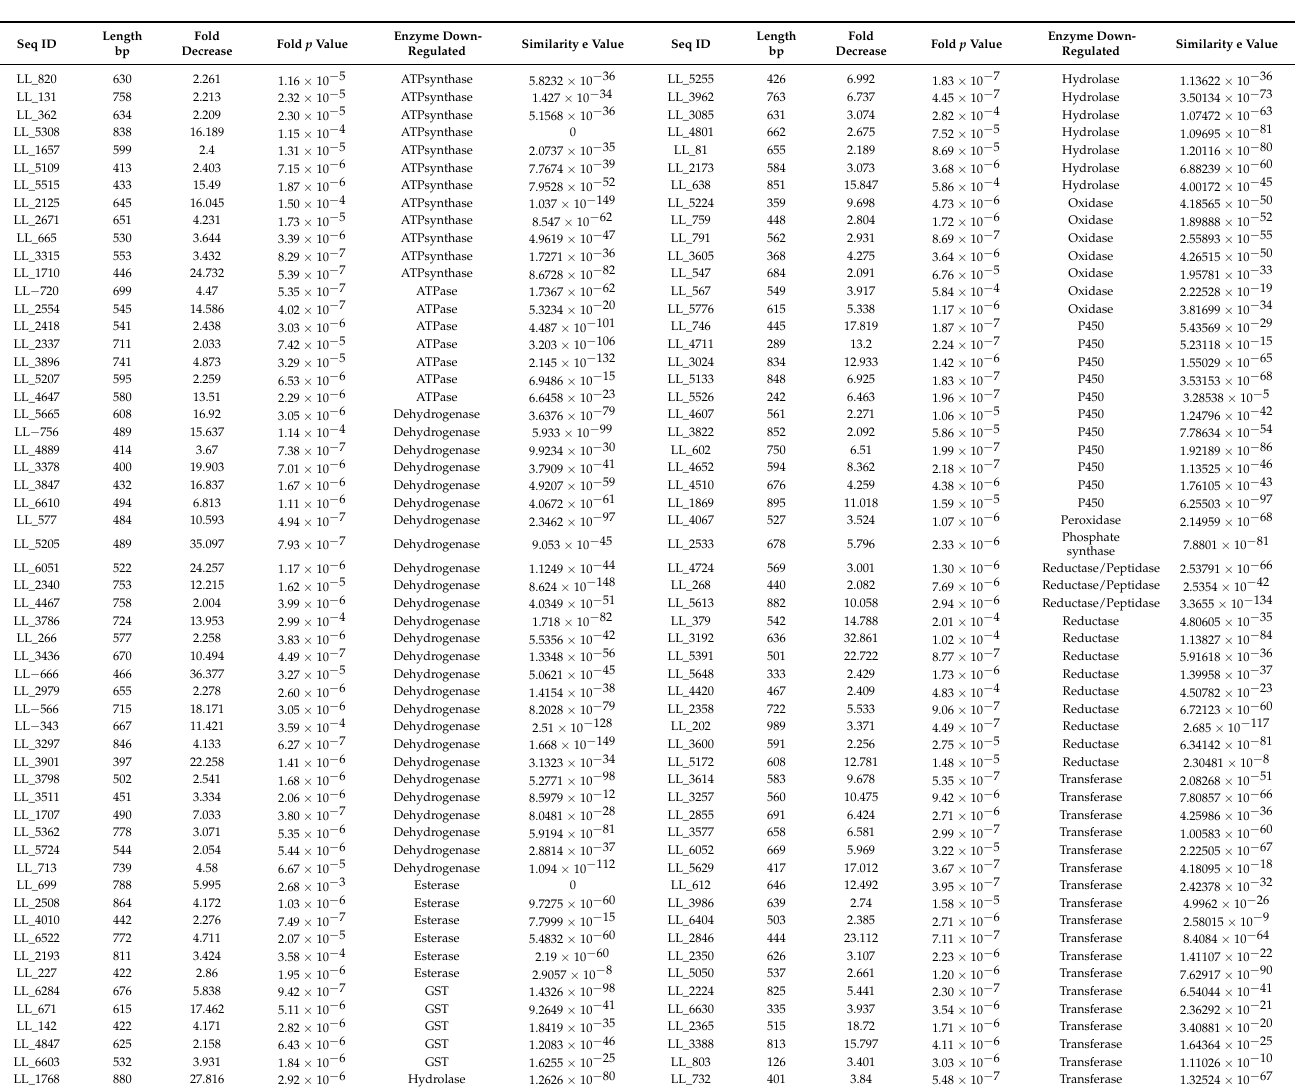
Table 2. Identification of 114 metabolic-enzyme-coding genes showing significantly down-regulated ( ≥ 2-fold) gene expressions in Arct2175FF resistant population using microarrays and analyzed with ArrayStar and Blat2go protocol (https://www.blast2go.com (accessed on 1 April